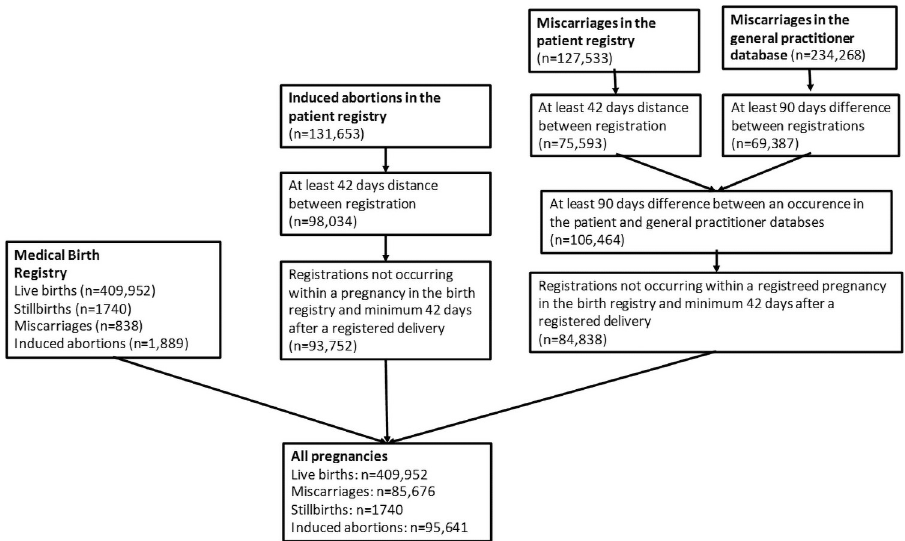
Fig 1. Illustration of identification of unique pregnancies across the birth, patient, and general practitioner databases. https://doi.org/10.1371/journal.pmed.1003603.g001 Table 1. Prevalence of chronic diseases prior to pregnancy among 593,009 pregnancies in Norway between 2010 and 2016. Group of diseases Diseases No. pregnancies to women with underlying No. pregnancies to women with chronic diseases ending chronic diseases (% out of all pregnancies) in a miscarriage (% out of exposed